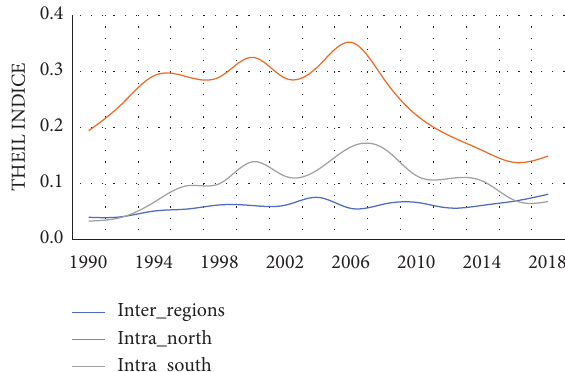
Figure 5: Theil decomposition of overall intercounty inequality, 1990–2018.